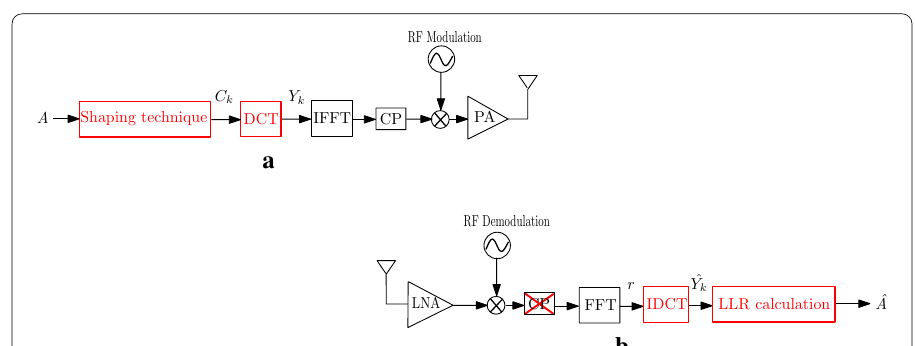
Shaping technique